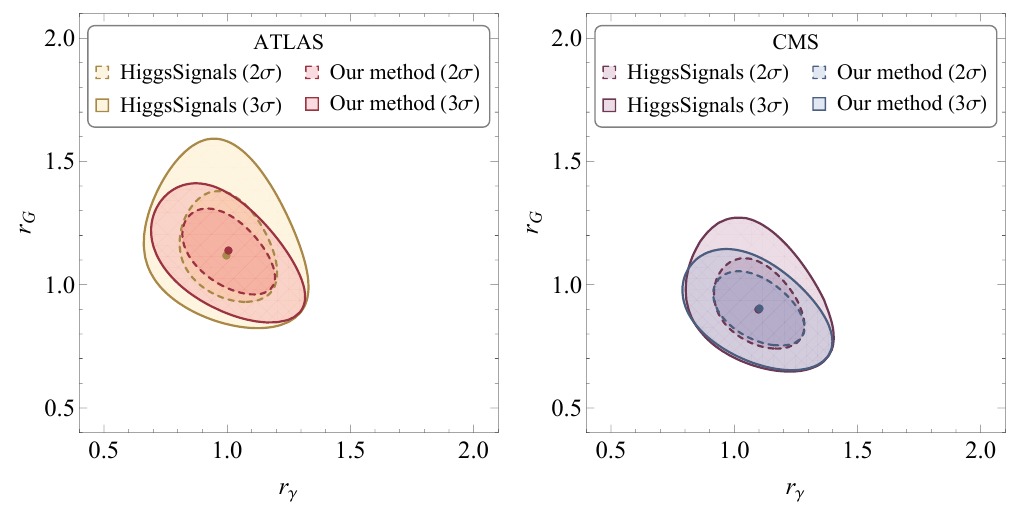
Figure 14 . A comparison of r (cid:0) r G (cid:13) joint (cid:12)ts from HiggsSignals and our (cid:12)tting method described in section 4 for ATLAS (left) and CMS (right) data (see text for more